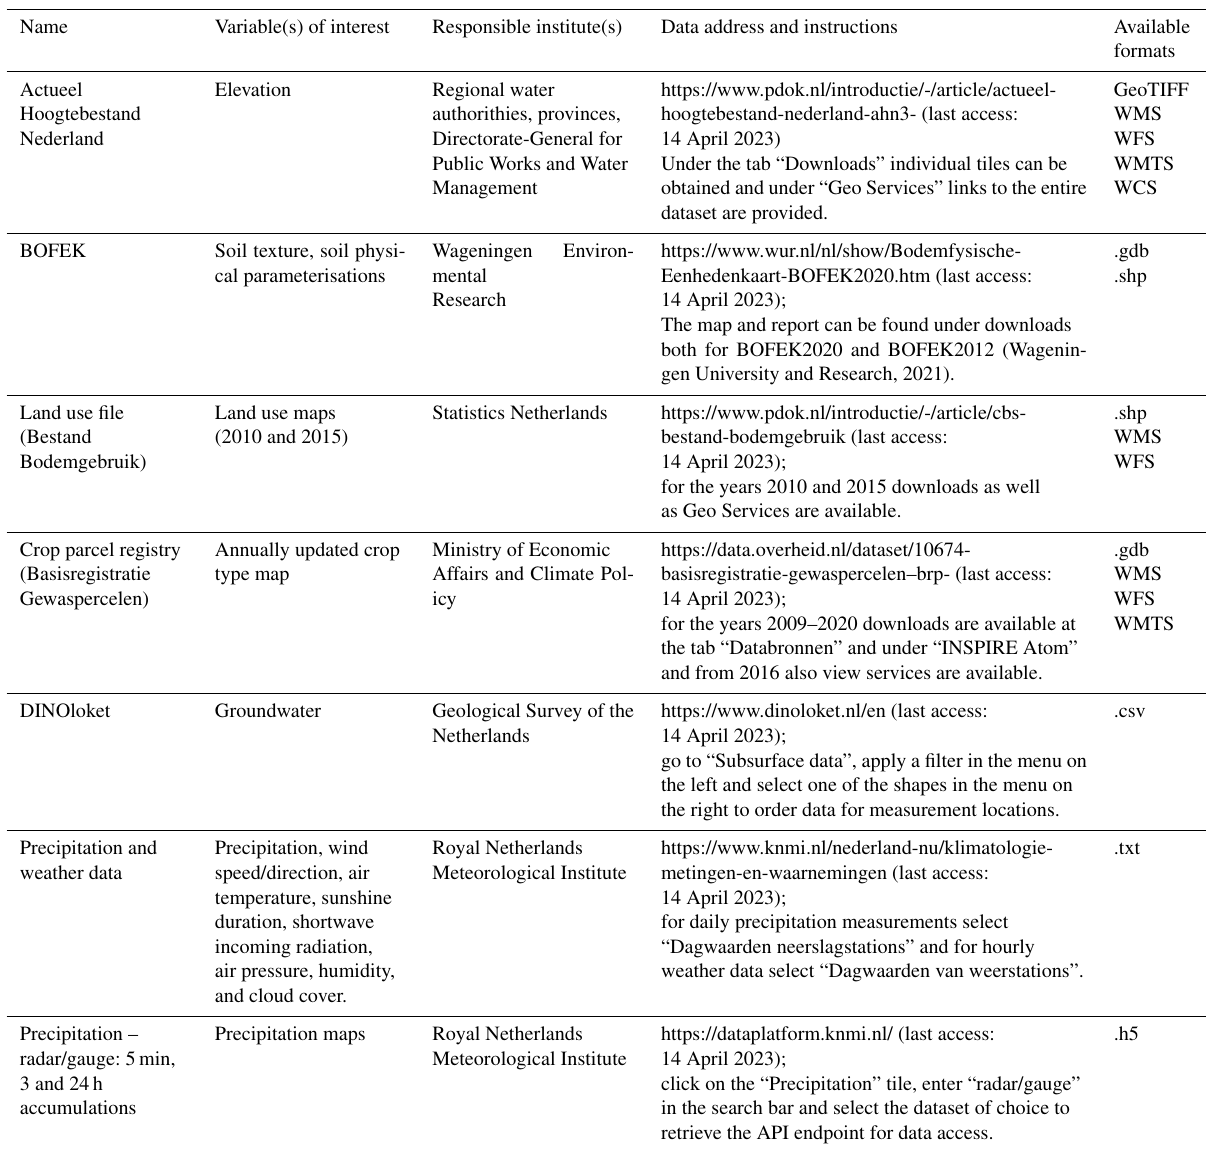
Table 7. Open third-party datasets available for the study region described in Sect.